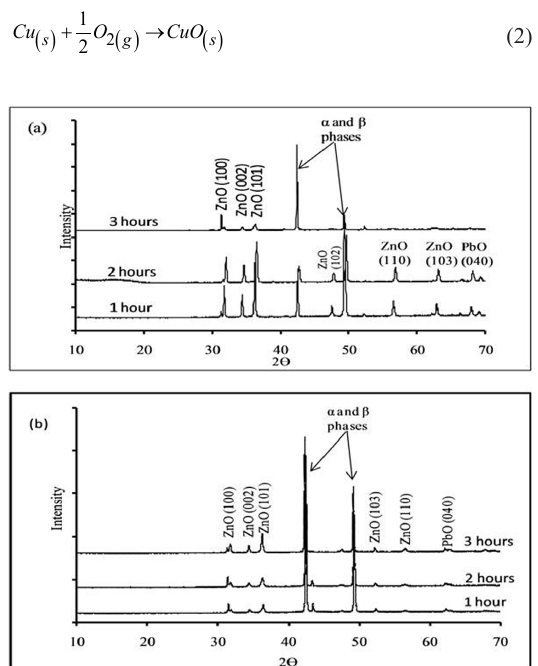
Figure 2. x-ray diffraction peaks for the oxide layer formed on the thermal oxidation of Cu- 32.02% Zn- 2.30% Pb alloy for 1, 2 and 3 hours in (a) N -5 wt. % O and (b) N2-12 wt.% O 2 2 2